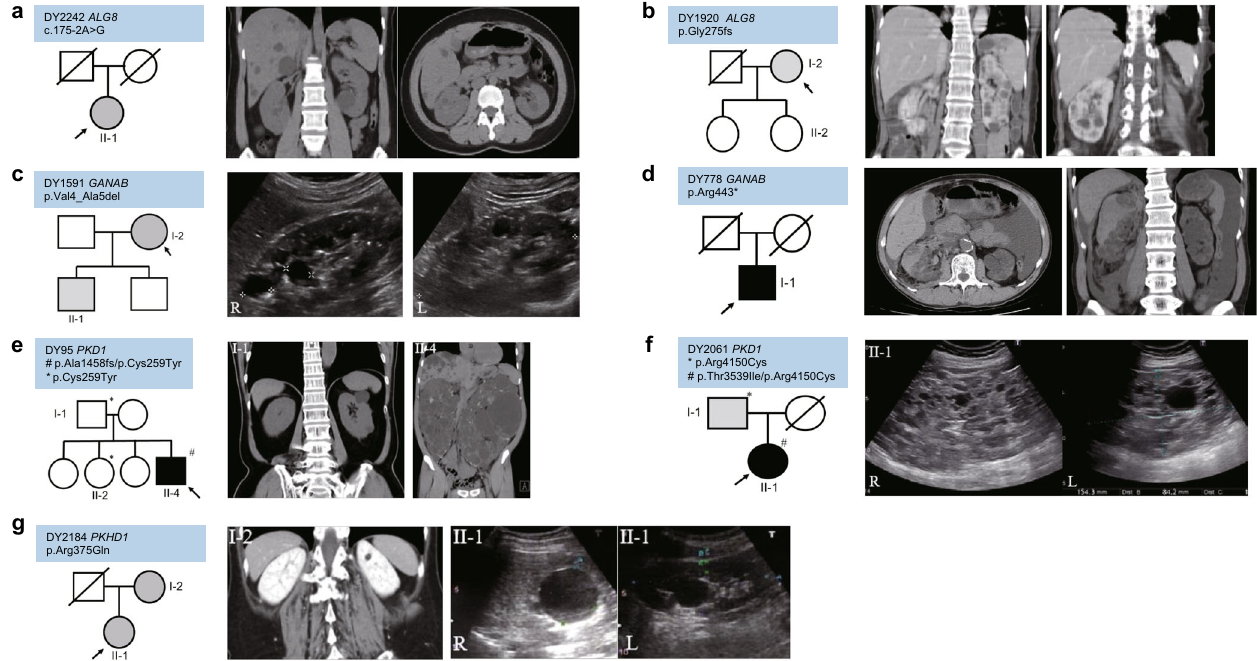
Fig. 5 Exemplary imaging in atypical cases of ADPKD. Genotypes and phenotypes of families with atypical APDKD. a Family DY2242: ALG8 c.175-2A>G variant. Abdominal CT showing bilateral polycystic kidney disease with liver cysts at the age of 44. b Family DY1920: ALG8 p.Gly275fs variant. Abdominal CT shows bilateral polycystic kidney disease without liver cyst at the age of 65. The index case and the daughter (II-1) also have a pathogenic SPAST p.Gly382Cys which is compatible with their clinical features of spastic paraplegia. c Family DY1591: GANAB p.Val4_Ala5del variant. Renal ultrasound shows bilateral multiple kidney cysts with preserved kidney contour at the age of 38. d Family DY778: GANAB p.Arg443* variant. Abdominal CT shows bilateral multiple kidney cysts and hematoma in right kidney due to right renal artery pseudoaneurysm rupture at the age of 48. The patient received continuous ambulatory peritoneal dialysis at the age of 47. Patients ’ clinical status at the time of images are illustrated by fi lled black symbols (ESKD) and gray symbols (CKD stage 1 – 3). e Family DY95: compound heterozygous PKD1 variants (p.Cys259Tyr/p.Ala1458fs). Abdominal computed tomography (CT) shows liver cysts and bilateral polycystic kidney disease at the age of 33 in II-4, and only a total of 4 cysts (2 on each kidney, CT showing cysts in the left kidney) at the age of 71 in